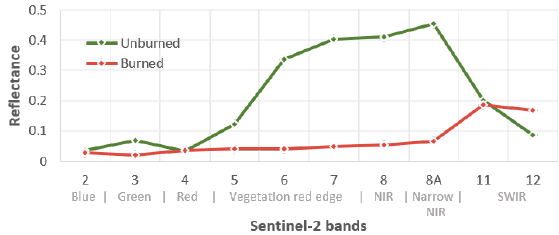
Figure 7 . Example spectral signatures of unburned vegetation in comparison to burned